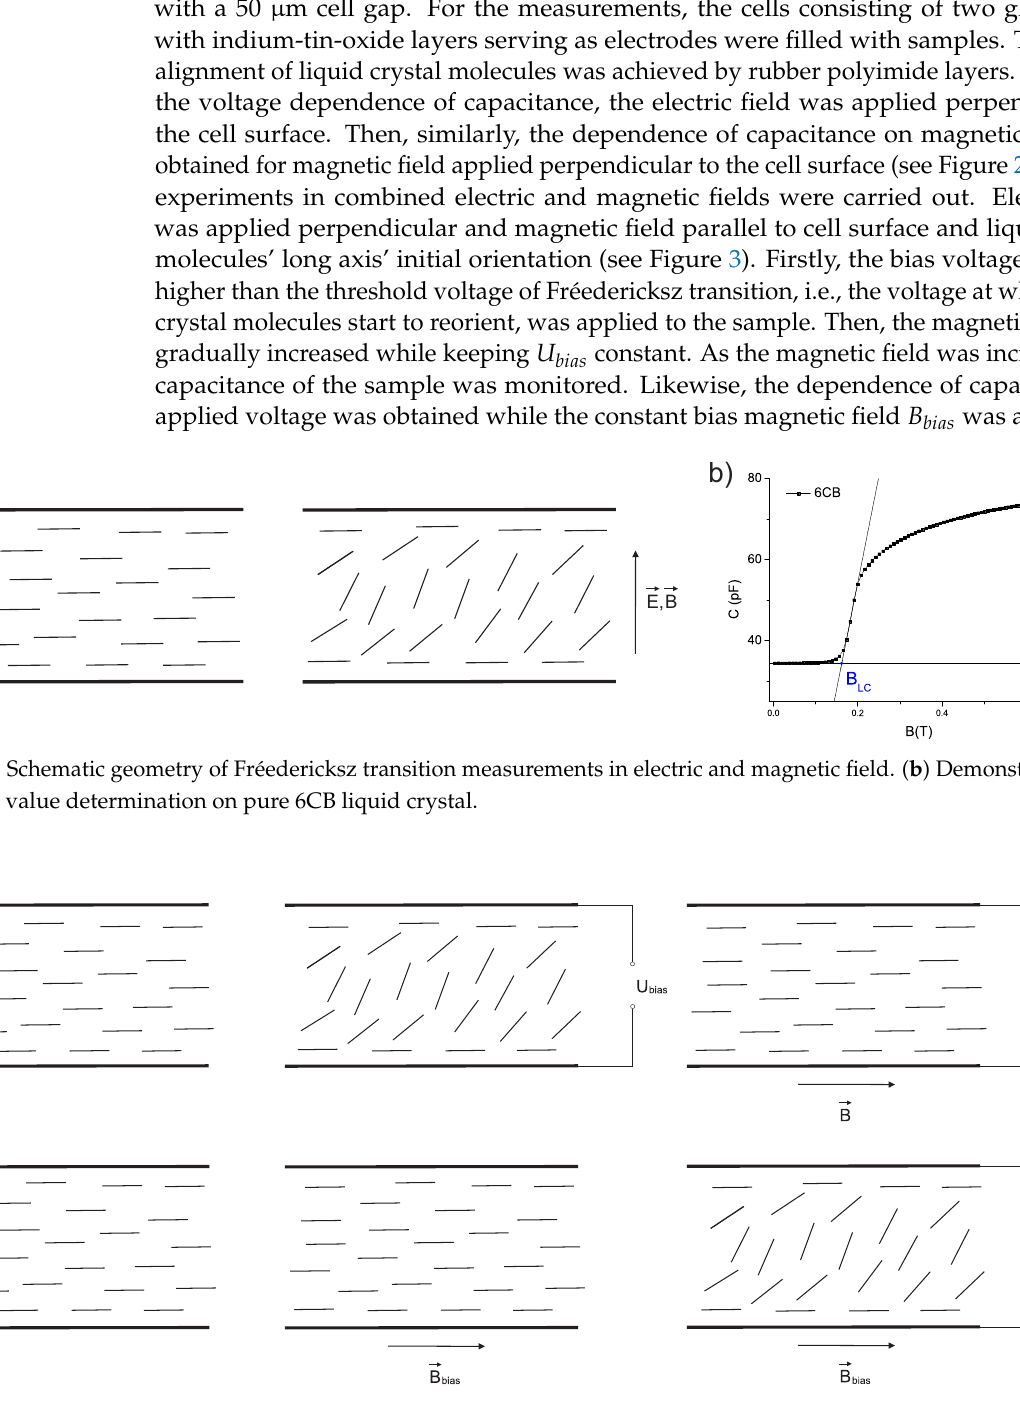
Figure 3. Schematic geometry for measurement of ( a ) magnetic Fréedericksz transition at applied bias voltage U bias and ( b ) electric Fréedericksz transition at applied bias magnetic field B bias